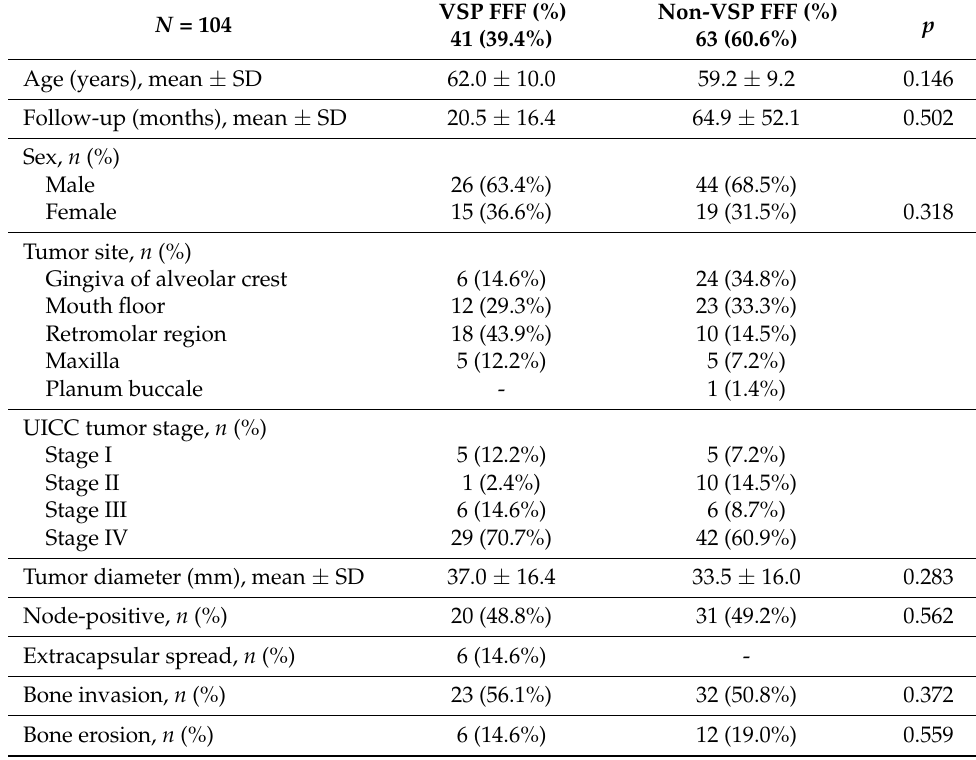
Table 1. Demographic parameters of study groups (VSP, virtual surgical planning; FFF, free fibula flap; SD, standard deviation; S; surgery; RT, radiation therapy; RCT, radiation, and chemotherapy). VSP FFF (%) N = 104 41